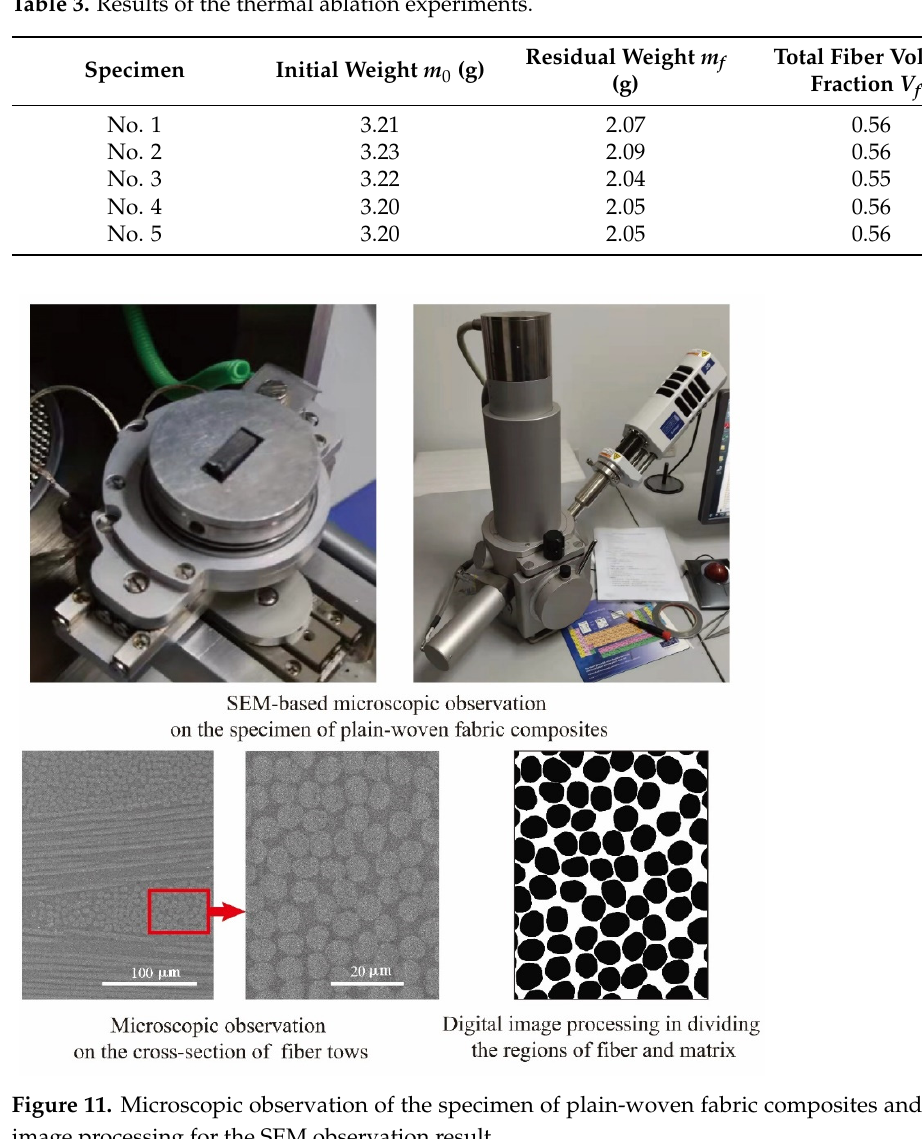
Table 4. Volume fraction parameters of the T300/Cycom970 plain-woven fabric composite.